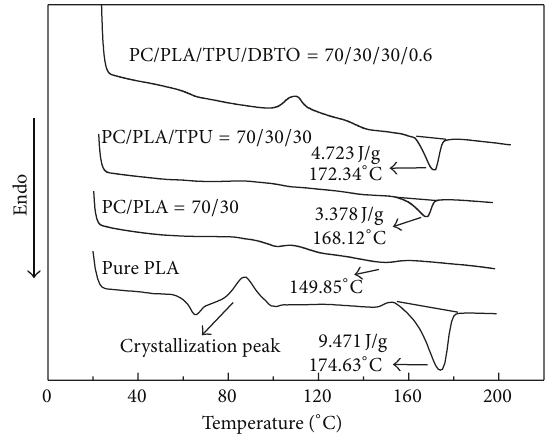
Figure 3: The DSC curves of PLA, PC/PLA, and PC/PLA/TPU